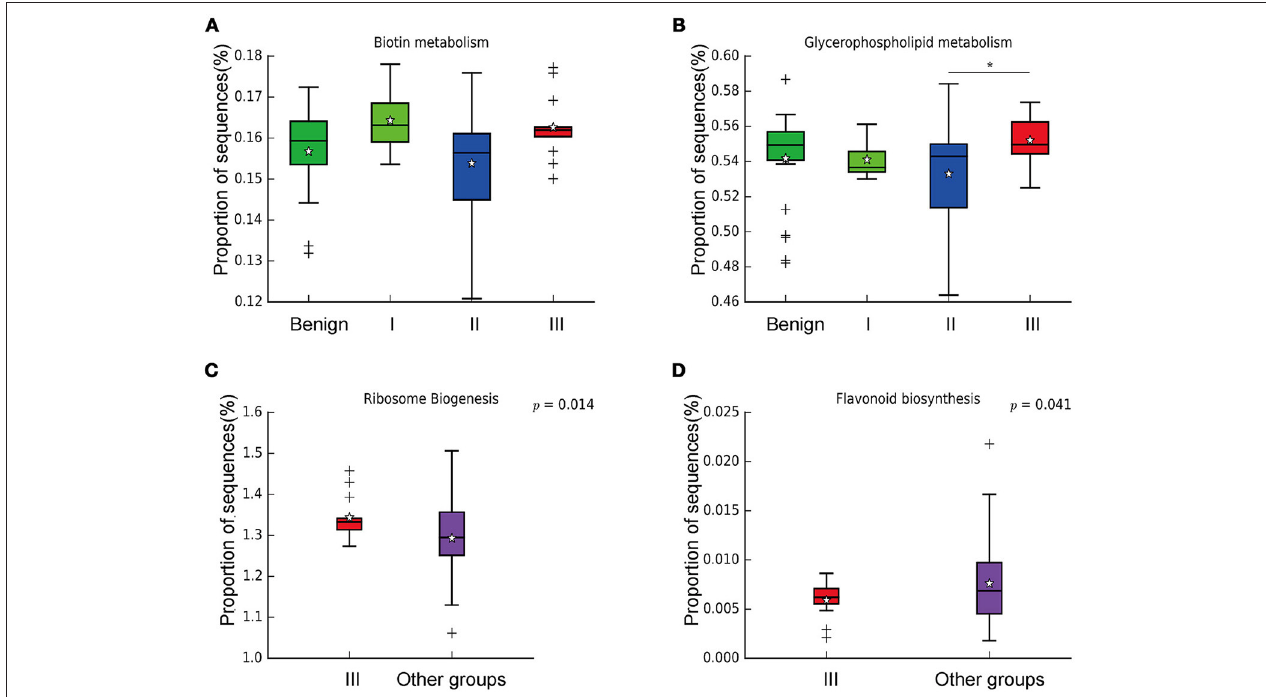
FIGURE 8 | Boxplot showing the significantly different KEGG pathways in benign, grade I, II, and III. (A) Biotin metabolism; (B) Glycerophospholipid metabolism; * indicates that grade III is significantly different with grade II ( P = 0.00264, Welch’s t -test); (C) Ribosome biogenesis; (D) Flavonoid